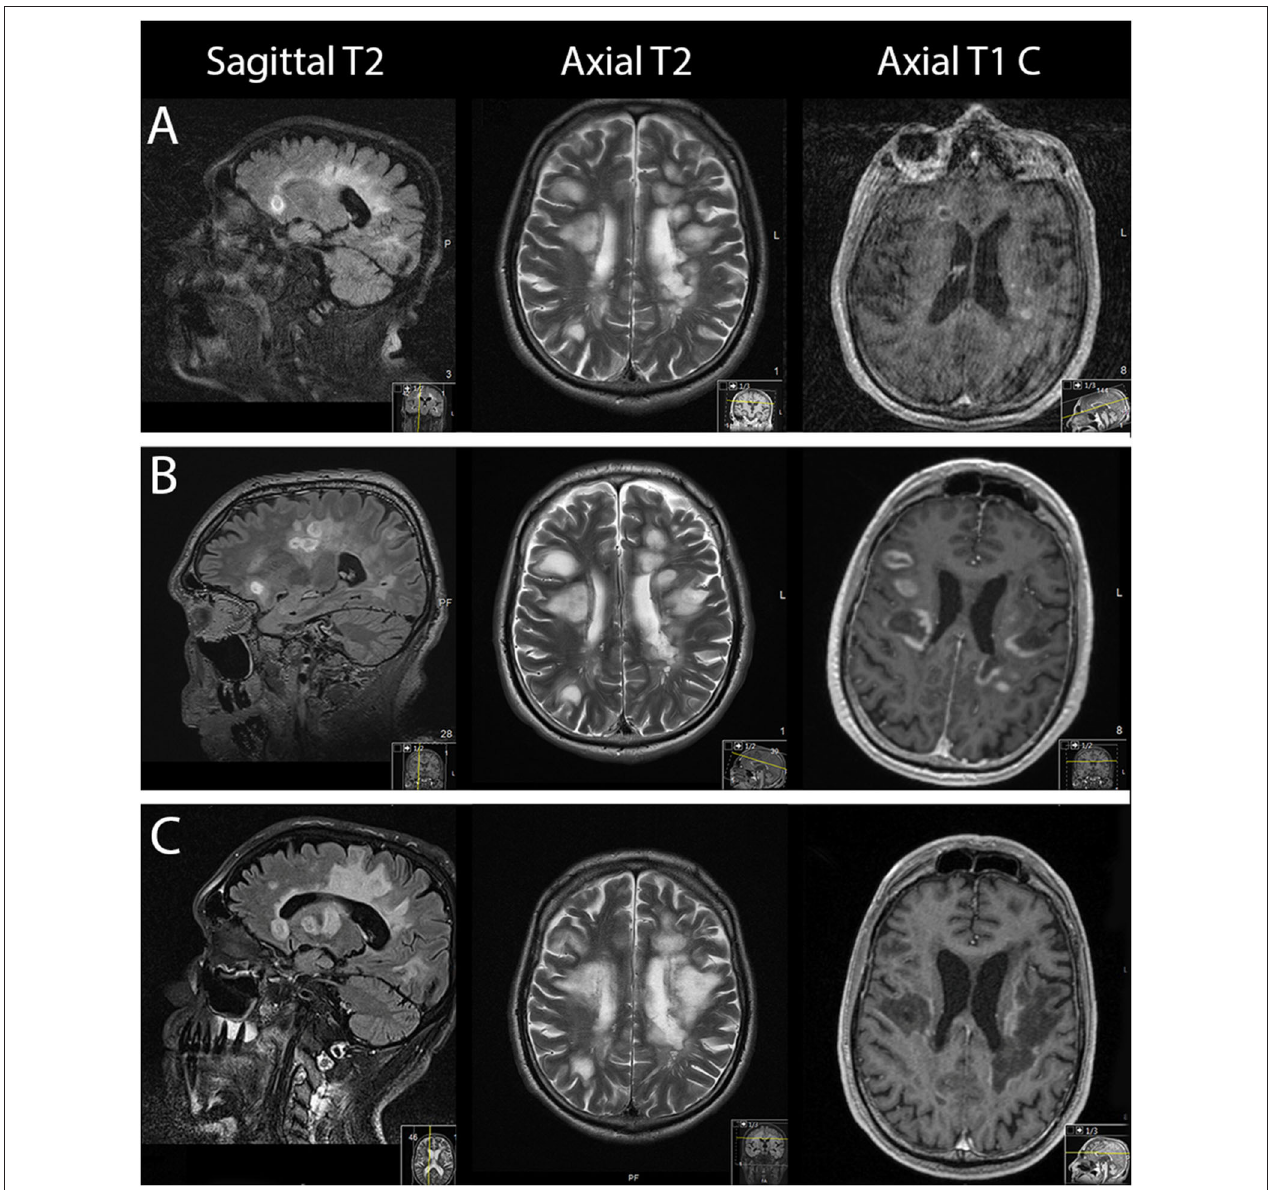
FIGURE 1 | From left to right: sagittal, axial MRI T2-weighted sequences and axial gadolinium contrast T1-weighted sequences. (A) On the day of admission. (B) Three days after admission. (C) Forty-one days after admission.